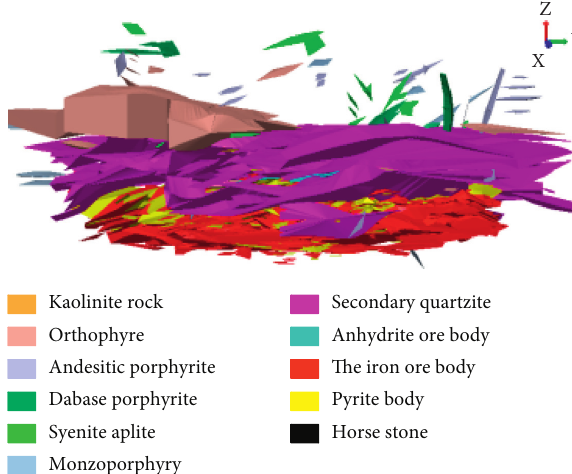
Figure 11: Ore body and rock mass model.